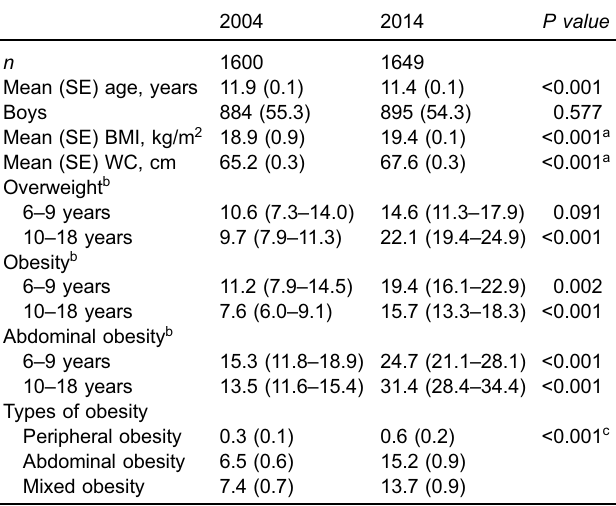
Table 1. Characteristics of children and adolescents in Beijing, 2004 and